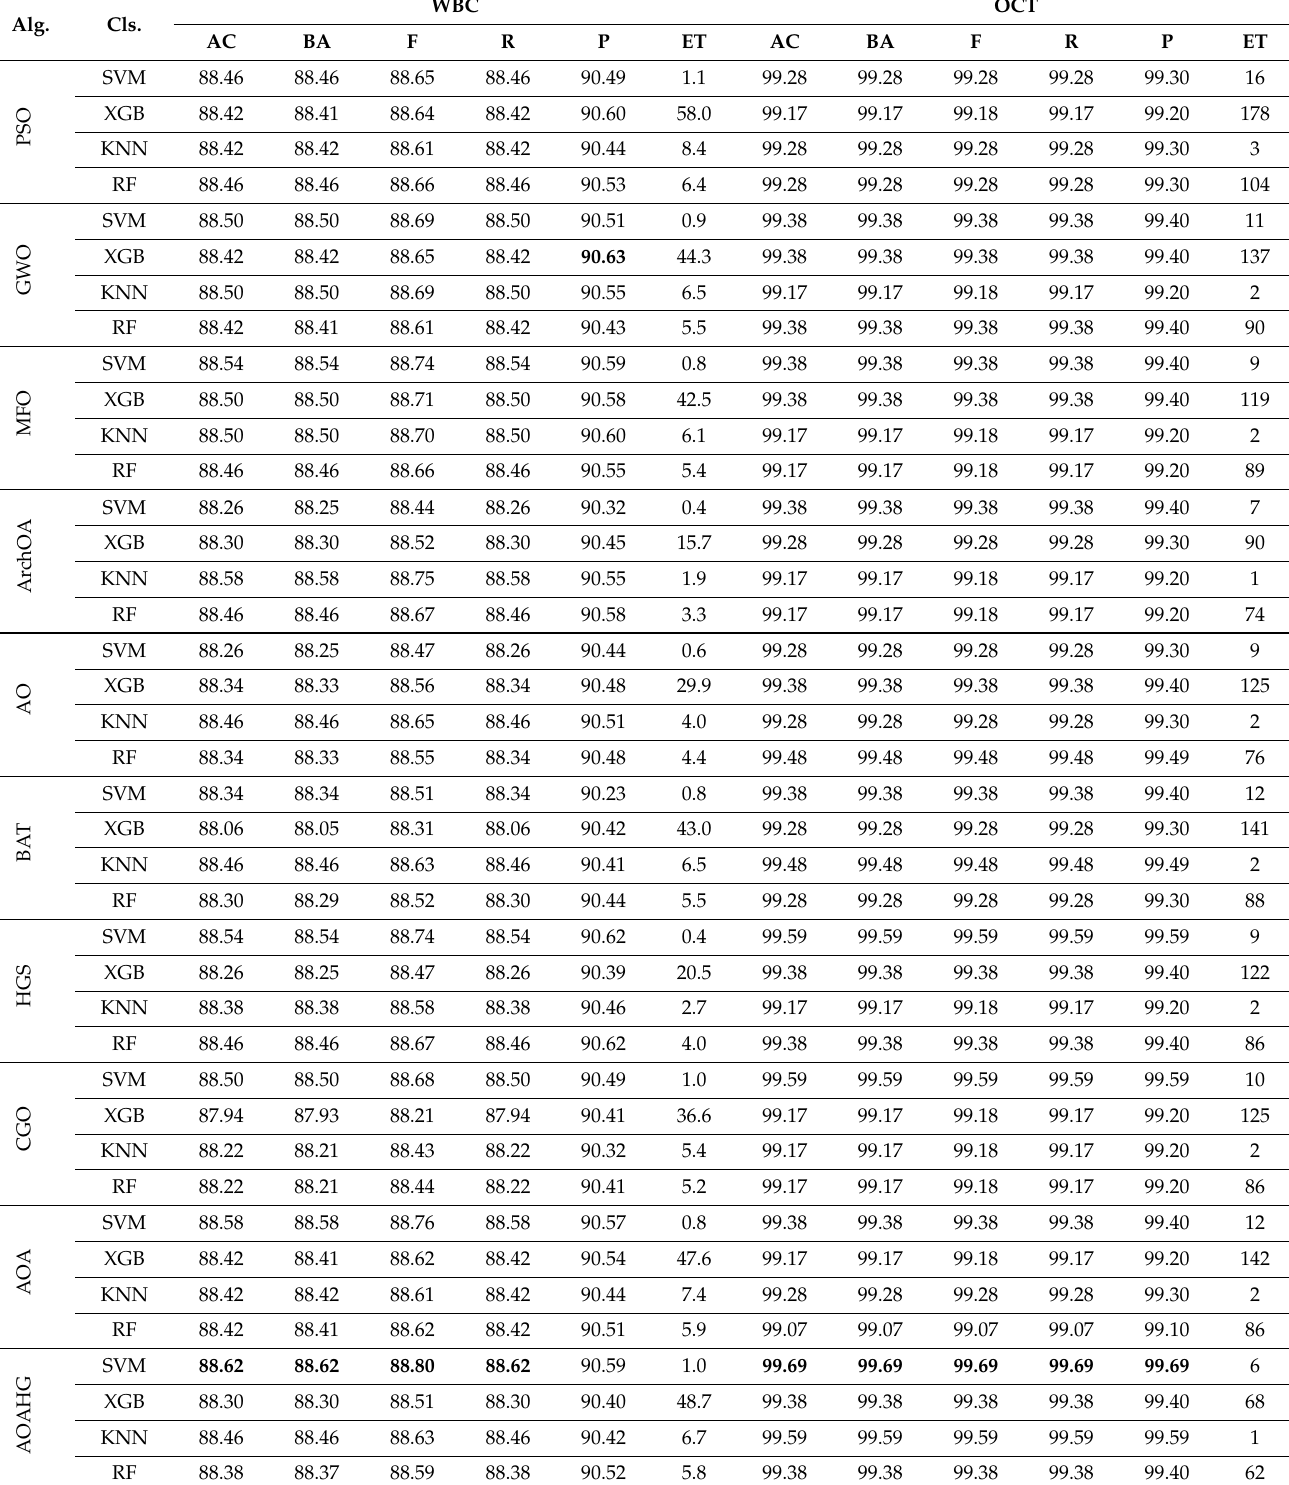
Table 3. Classification Results (%) of each FS algorithm using WBC dataset and OCT dataset. ET is the execution